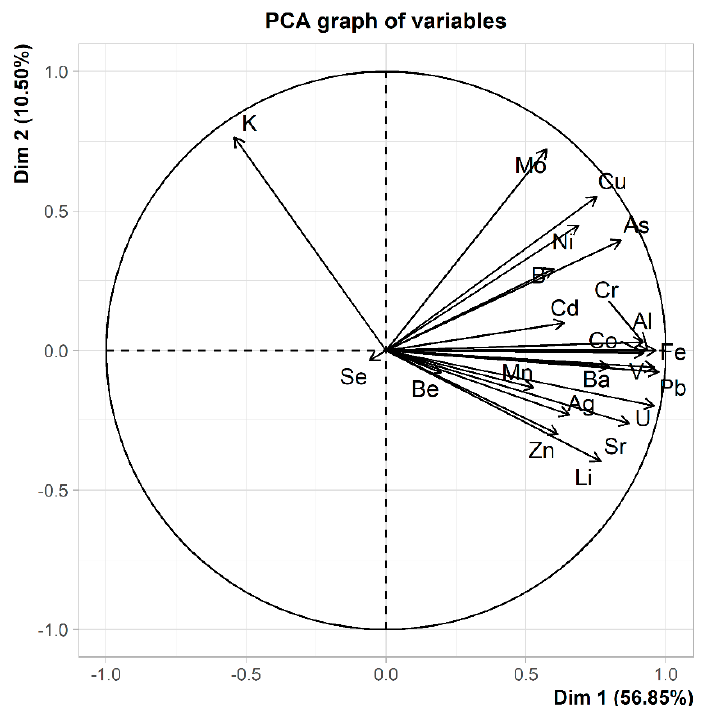
Figure 4. PCA plot—contributions of variables (elements investigated).